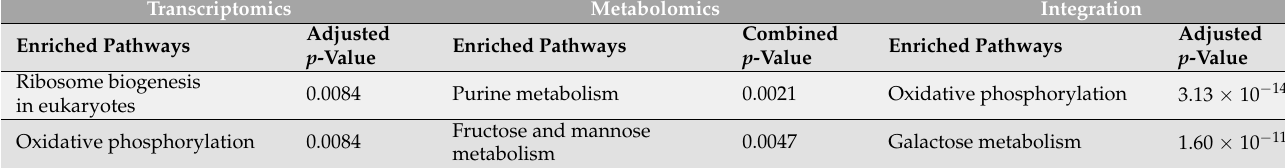
Table 3. Single- and multi-omics integration results for gpa2 ∆ . First block shows GSEA for transcrip- tomics with adjusted p -value < 0.05, arranged in ascending order; second block shows MetaboAn- alystR pathway enrichment analysis for metabolomics with combined p -value < 0.05, arranged in ascending order; third block shows MetaboAnalystR joint pathway analysis with adjusted p -value < 0.05, arranged in ascending order, as detailed in